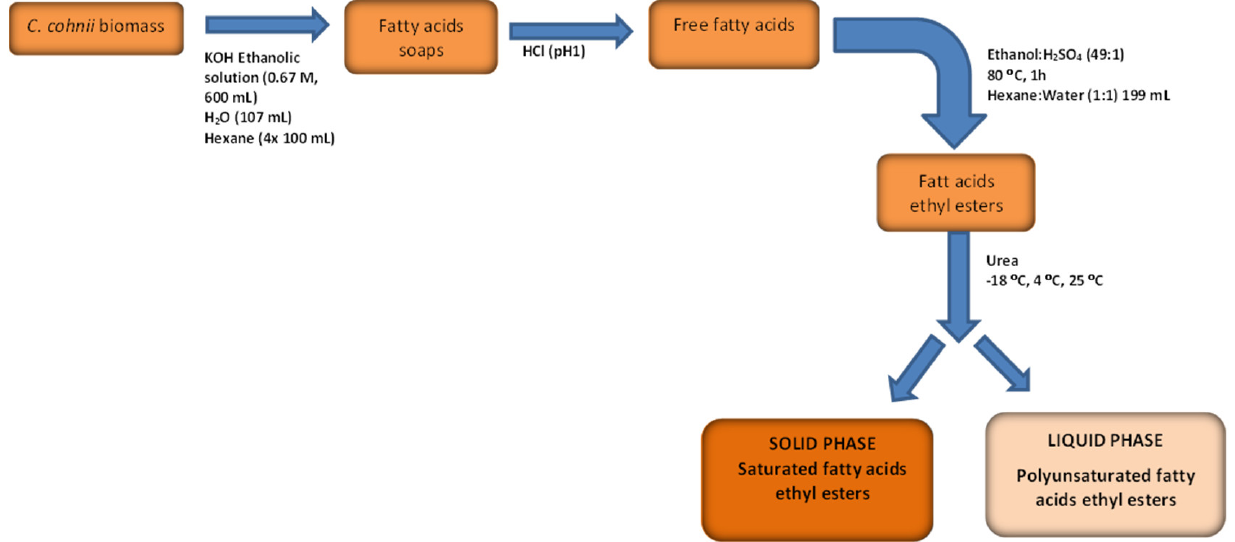
Figure 1. C. cohnii biomass saponification and fatty acid ethyl esters fractionation using urea complexation at different temperatures.